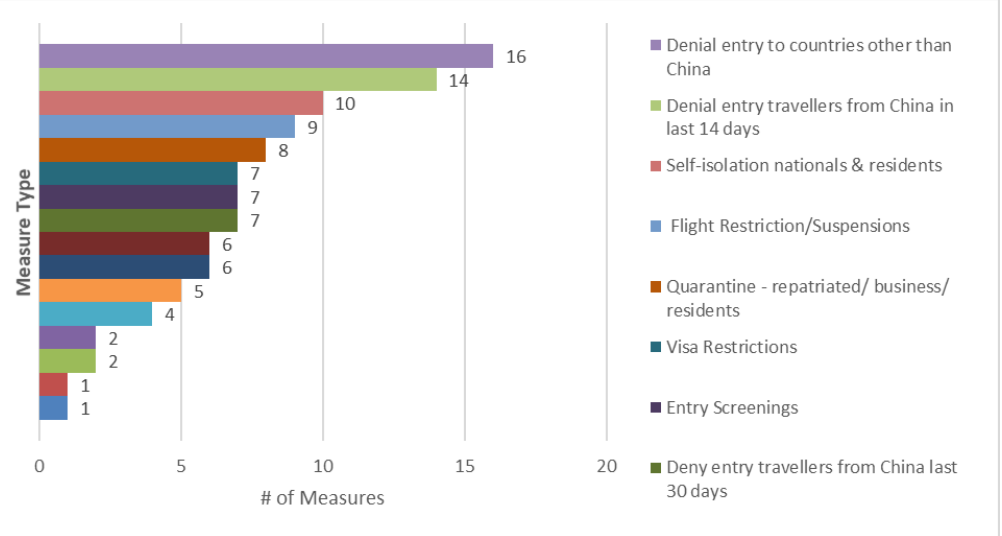
Figure 1. Number of additional health measures by type